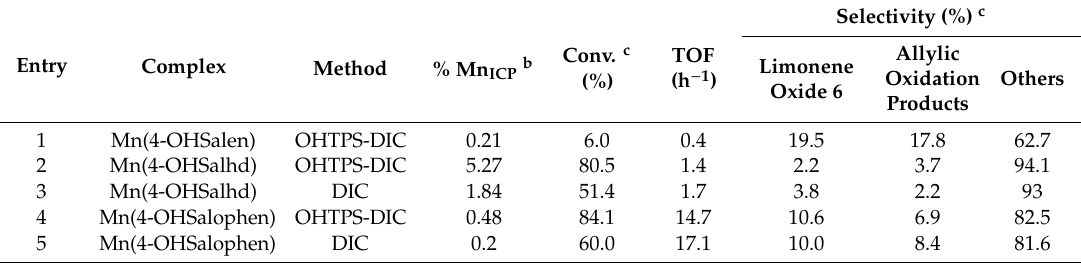
Table 7. Limonene 2 oxidation catalyzed by MCM41-supported Mn(Salen) complexes a (adapted from reference [37]).